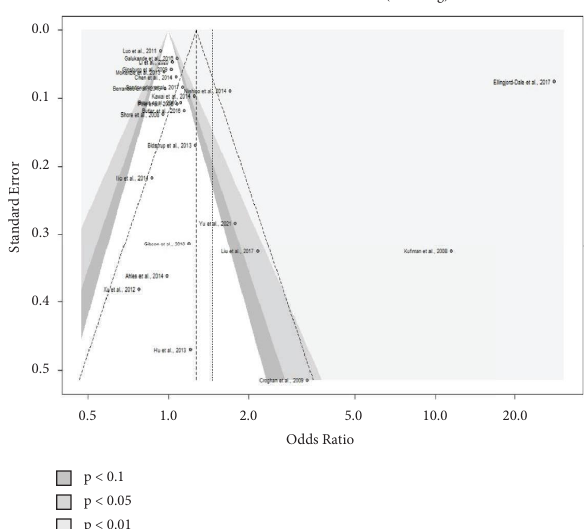
Figure 6: Contour-enhanced funnel plot of all studies of smoking.